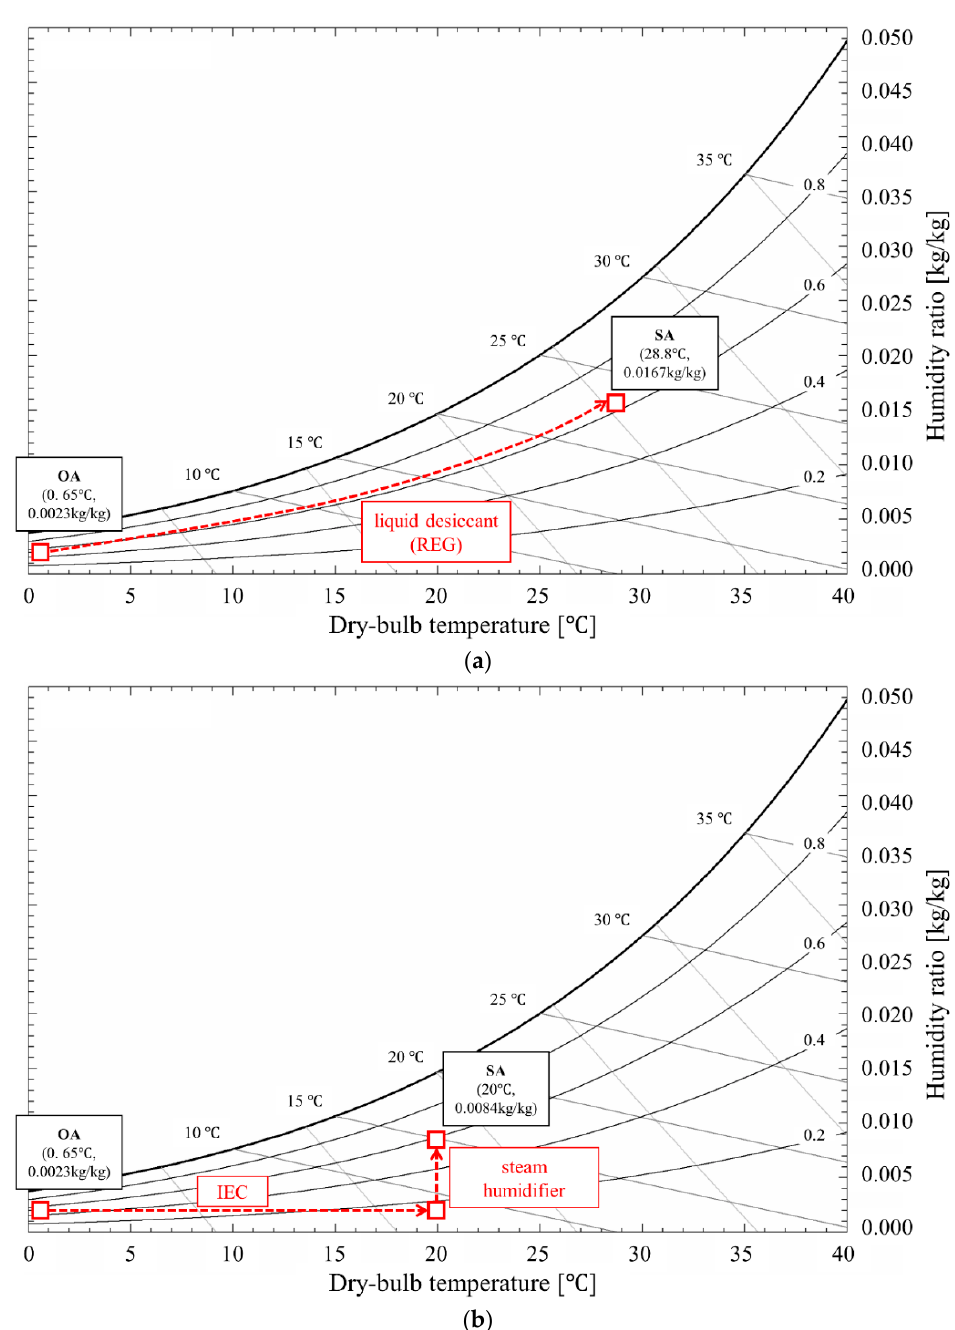
Figure 12. Performances of ( a ) modified and ( b ) existing systems on the psychrometric chart.